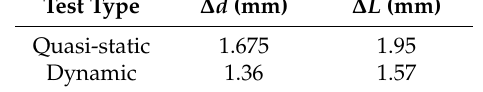
Figure 6. Finite element model of the specimen in notch area. 2.2.2. Simulation of Dynamic Tests As stated above, the dynamic tests were conducted on the “Flying wedge” testing apparatus. Therefore, the major parts of the Flying Wedge involved in pulling the specimen were considered in the finite element model of the dynamic test simulations. The simulations were performed using the